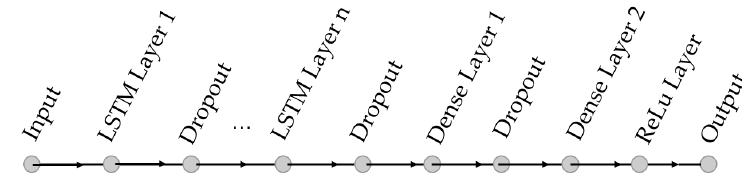
Figure 5. LSTM network structure.